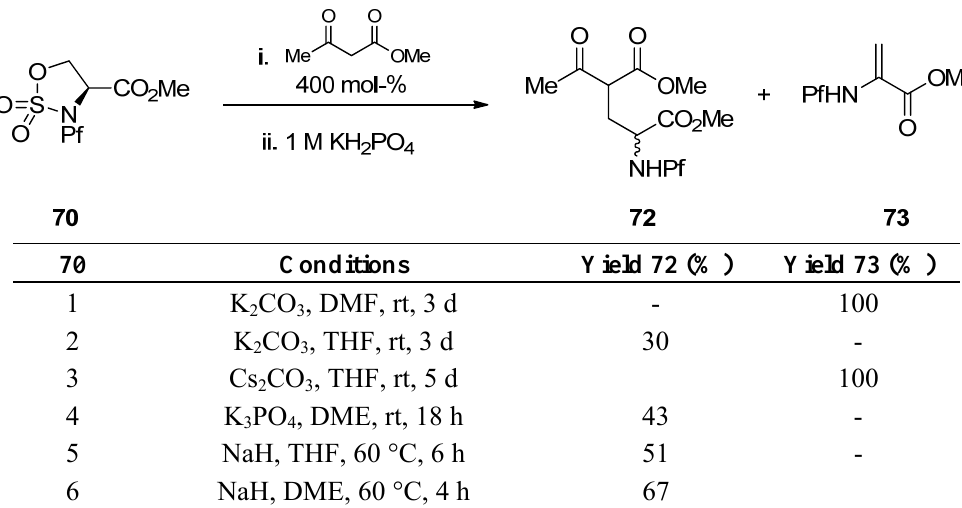
Table 10. Addition of β -ketoester to sulfamidate 70